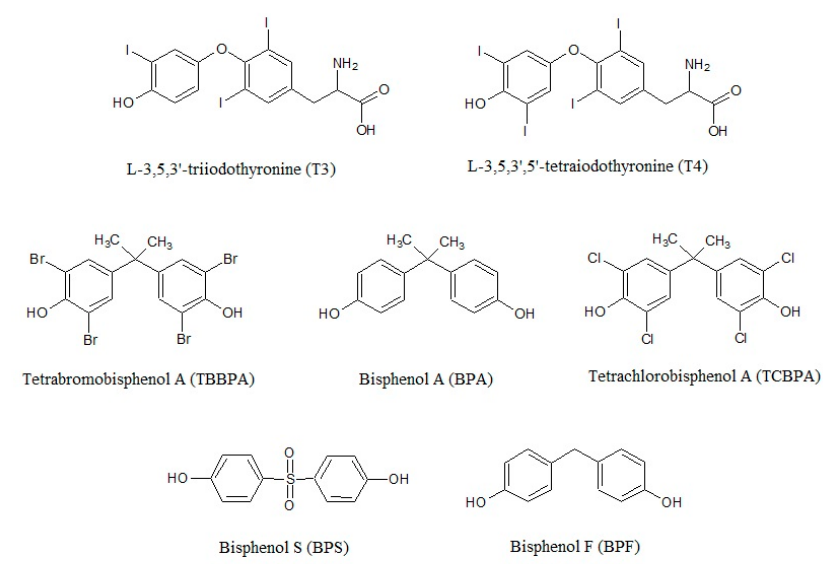
Figure 1. Bisphenol A, its analogues bisphenol F and bisphenol S, and the halogenated derivatives tetrabromobisphenol A and tetrachlorobisphenol A show a high degree of similarity with the thyroid hormones in regards the chemical structure.